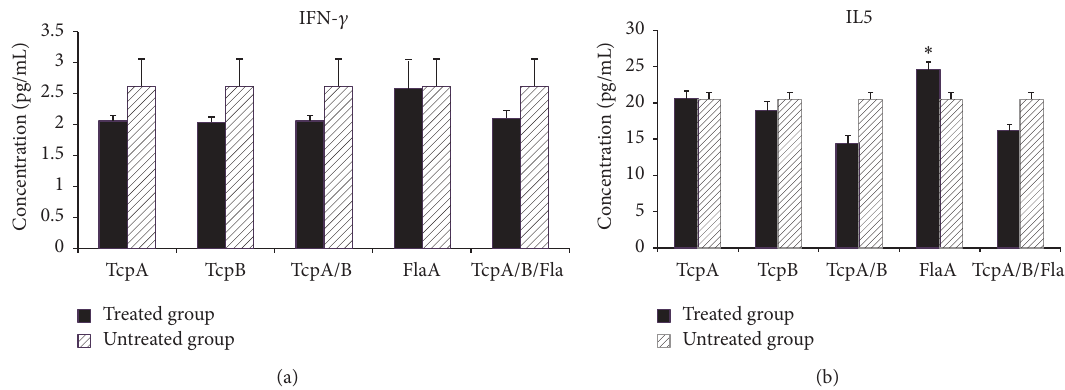
Figure 4: Quantitative ELISAanalysis of IFN- 𝛾 (a) and IL5 (b)measured in theserumof miceimmunized with specificrecombinant proteins. Significant differences were designated as ∗ 𝑃 < 0.05 .